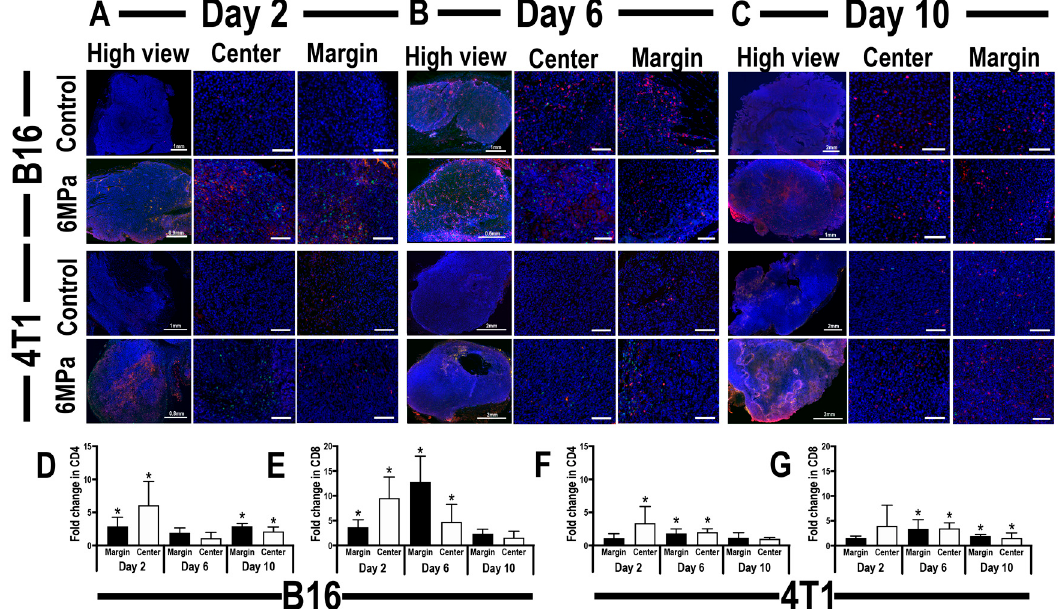
Figure 5. Representative immunohistochemistry staining of CD4 (green), CD8 (red), and DAPI (blue) in tumor sections of mouse xenograft B16 melanoma tumor model ( upper panel ) or 4T1 breast cancer model ( lower panel ), after reaching 5 mm in diameter, 24 h post-pFUS ( second and fourth rows ) or untreated tumors ( first and third rows ). High-view image of B16 or 4T1 tumors on day 2 ( A , left ), day 6 ( B , left ), or day 10 ( C , left ); scale 100 µ m. Lower view of center tumor areas in B16 or 4T1 tumors on day 2 ( A , middle ), day 6 ( B , middle ), or day 10 ( C , middle ); scale 100 µ m. Lower view of tumor periphery areas in B16 or 4T1 tumors on day 2 ( A , right ), day 6 ( B , right ), or day 10 ( C , right ); scale 100 µ m. Quantitative analysis of time-related changes in CD4 + ( D ) or CD8 + ( E ) cell localization within center or margin areas of B16 tumors. Quantitative analysis of time-related changes in positive CD4 + ( F ) or CD8 + ( G ) cell localization within center or margin areas of 4T1 tumors. Asterisks indicate statistically significant elevations ( p < 0.05; ANOVA) between the pFUS-treated group to a time-matched untreated control.